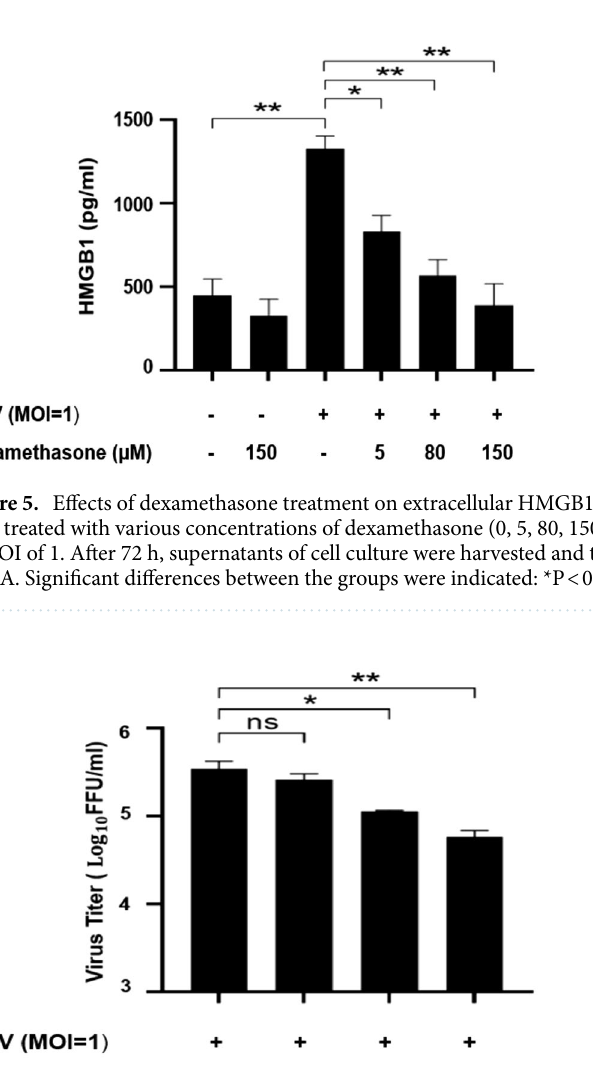
lular HMGB1 has been correlated to neuroinvasion of ZIKV and Japanese encephalitis virus (JEV), possibly via